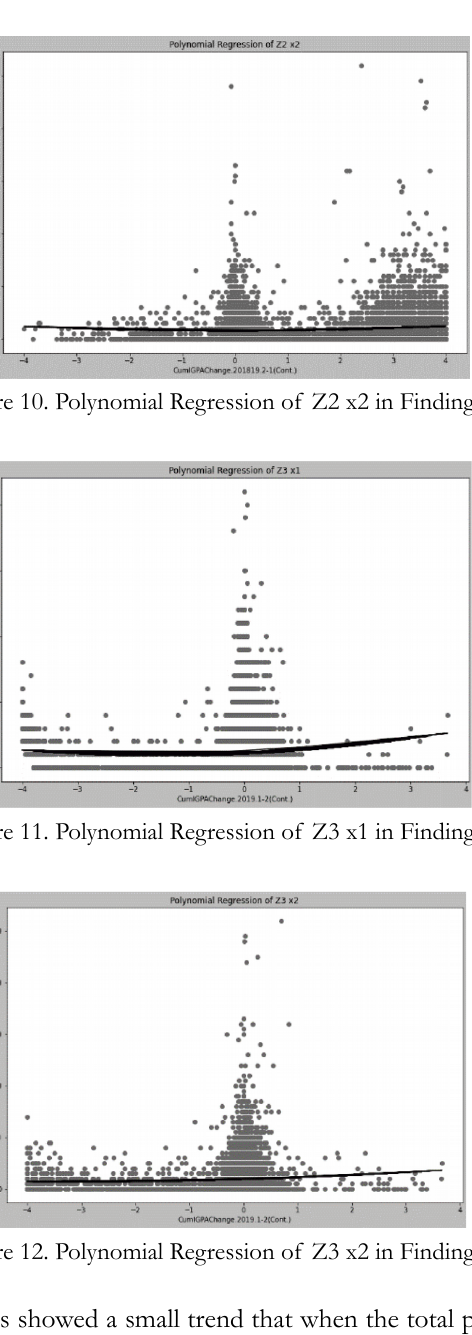
Figure 9. Polynomial Regression of Z2 x1 in Finding 1